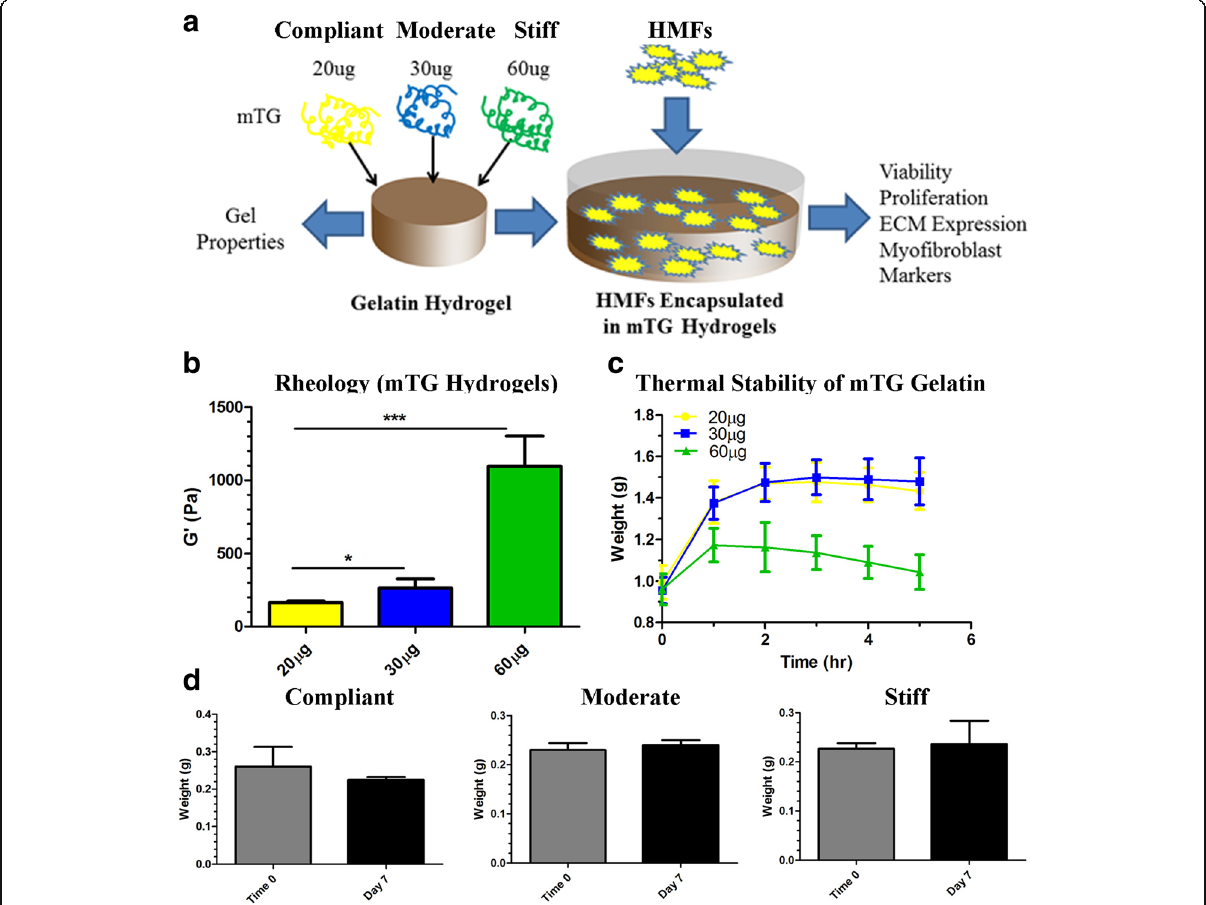
Fig. 2 Hydrogel properties. a Schematic of hydrogel setup and downstream assays. b Rheology was performed on hydrogels cross-linked with 20, 30 and 60 μ g/ml mTG. As mTG concentration increased, the elastic modulus (G ’ ) of the hydrogels corresponding increased. The most significant change in G ’ is shown for hydrogels cross-linked with 60 μ g/ml mTG. c Hydrogels cross-linked with 20, 30 and 60 μ g/ml mTG were examined over a 5 h period for changes in hydrogel weight following incubation with PBS. Hydrogels cross-linked with 20 and 30 μ g/ml mTG exhibited increases in hydrogel weight during the culture period indicative that the gels had swollen during this time frame. Hydrogels cross-linked with 60 μ g/ml mTG exhibited a slight, but not significant decrease in hydrogel weight during the incubation period. d Differences in the dry hydrogel weight were examined for HMF encapsulated hydrogels at the start of the experiment (time 0) and at the end of the experiment (day 7). Hydrogel weights were similar between time 0 and day 7 measurements for each of the mTG hydrogels. * p ≤ 0.05; ** p ≤ 0.01; *** p ≤